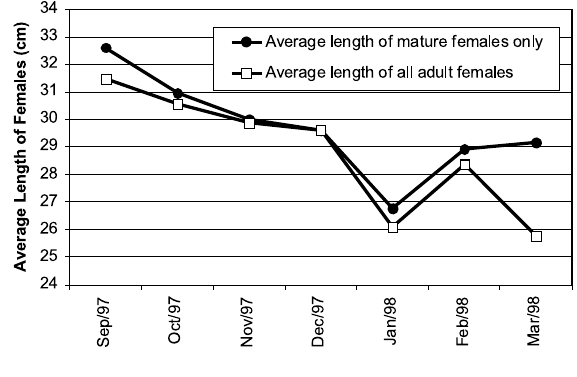
Fig. 3. Monthly average gonadosomatic index (GSI) of females and monthly average of hepatosomatic index of males and females of Menticirrhus littoralis . Animals captured at Cidreira’s fishing pier, Rio Grande do Sul, Brazil, from June 1997 to May 1998.